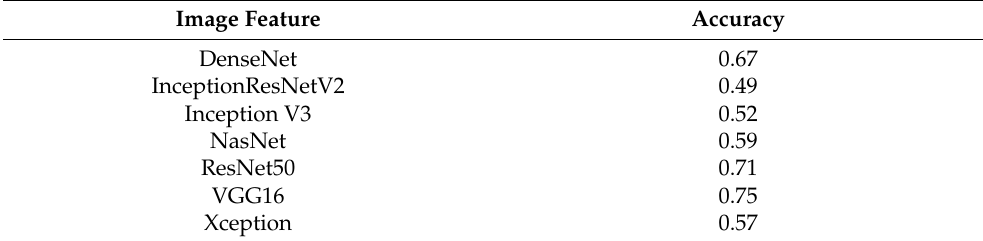
Table 6. Comparison of accuracies for image features only.